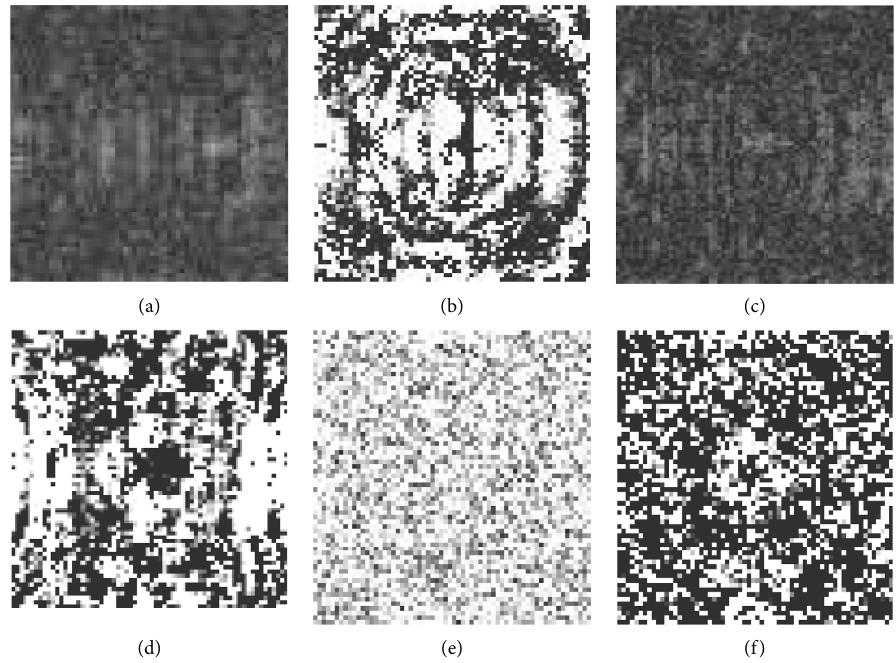
Figure 8: Decrypted simulation results: (a) intensity information when one of the circular harmonic keys, RPM corresponding phase; (c) intensity information when one of the d information when the measurement matrix Ψ is incorrect and (f) the corresponding phase.